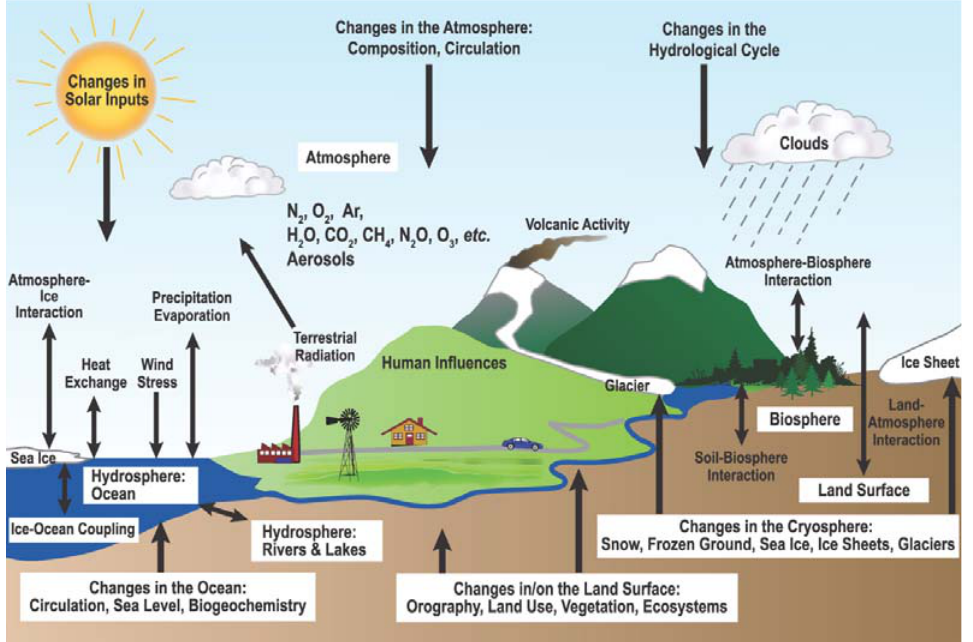
Figure 1. Schematic view of the components of the climate system, their processes and interactions